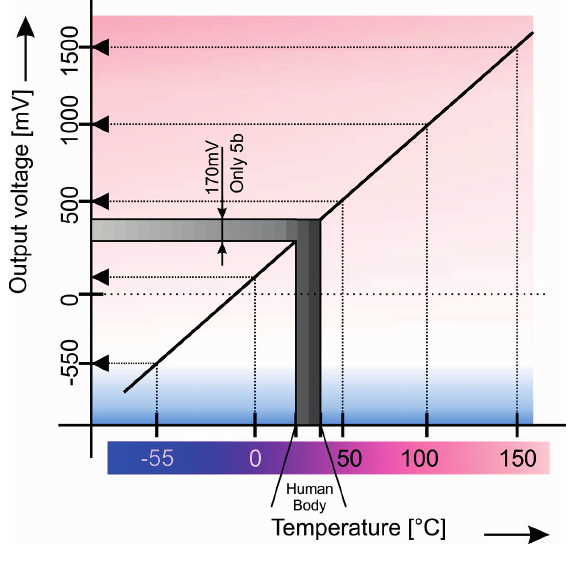
Figure 1. Human body temperature range vs. sensor measuring